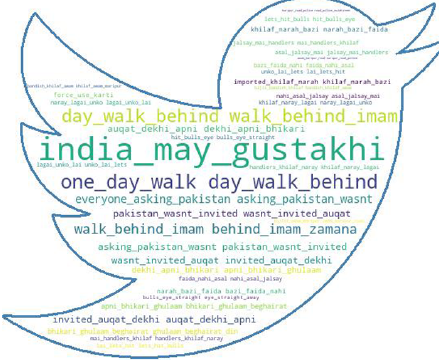
Figure 4. Trigram with positive words.